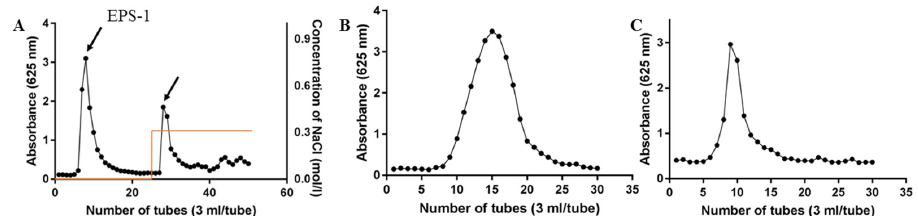
Figure 1. Extraction of crude exopolysaccharides from the fermentation broth of R. nigricans .